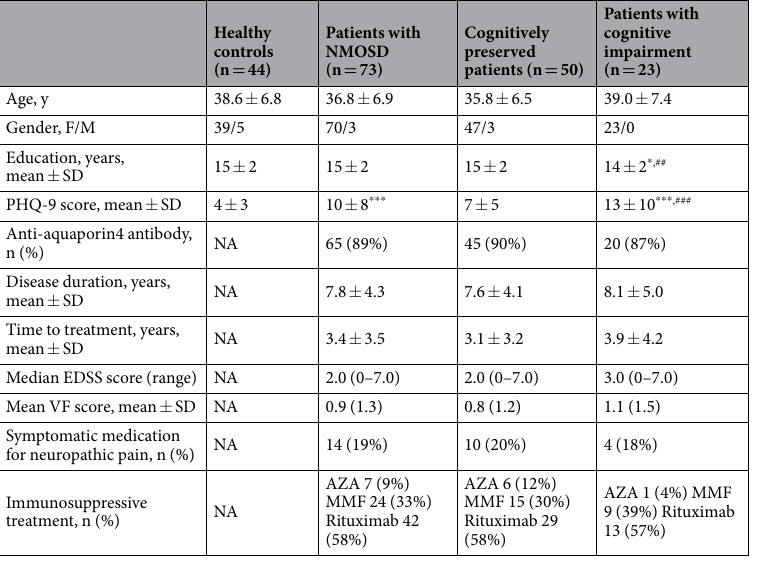
Table 1. Demographic and clinical characteristics of healthy controls, patients with NMOSD, and the cognitively preserved and impaired patient groups. Abbreviations: BFI = Brief Fatigue Inventory; EDSS = Expanded Disability Status Scale; HCs = healthy controls; NA = not applicable; NMOSD = neuromyelitis optica spectrum disorder; PHQ-9 = Patient Health Questionnaire-9; SD = standard deviation; AZA = azathioprine; MMF = mycophenolate mofetil. Post hoc analysis was performed using Bonferroni correction. * p < 0.05 compared to healthy controls. ** p < 0.01 compared to healthy controls. *** p < 0.001 compared to healthy controls. # p < 0.05 compared to cognitively preserved patients. ## p < 0.05 compared to cognitively preserved patients. ### p < 0.05 compared to cognitively preserved